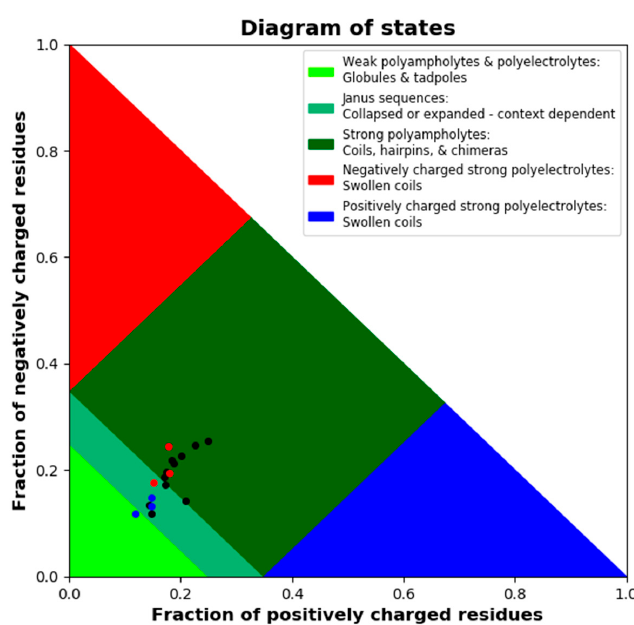
Figure 3. Das-Pappu phase diagram calculated using local CIDER including all 18 A. thaliana LEA_4 proteins. LEA7 clade members are plotted in blue, COR15A clade members in red, the remaining LEA_4 proteins in black.